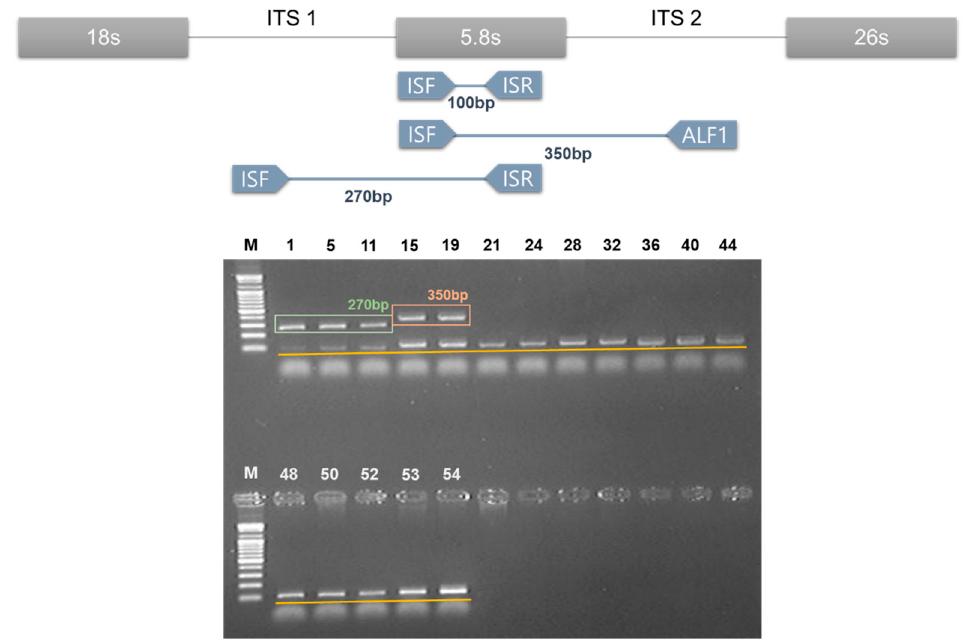
Figure 3. Multiplex PCR products of the primer set AVF1/ISR/ISF/ALF1 from randomly chosen samples in Table 1 for distinguishing Amomi Fructus from its adulterants. Lane numbers above: The sample number listed in Table 1. M: 100 bases ladder size marker.